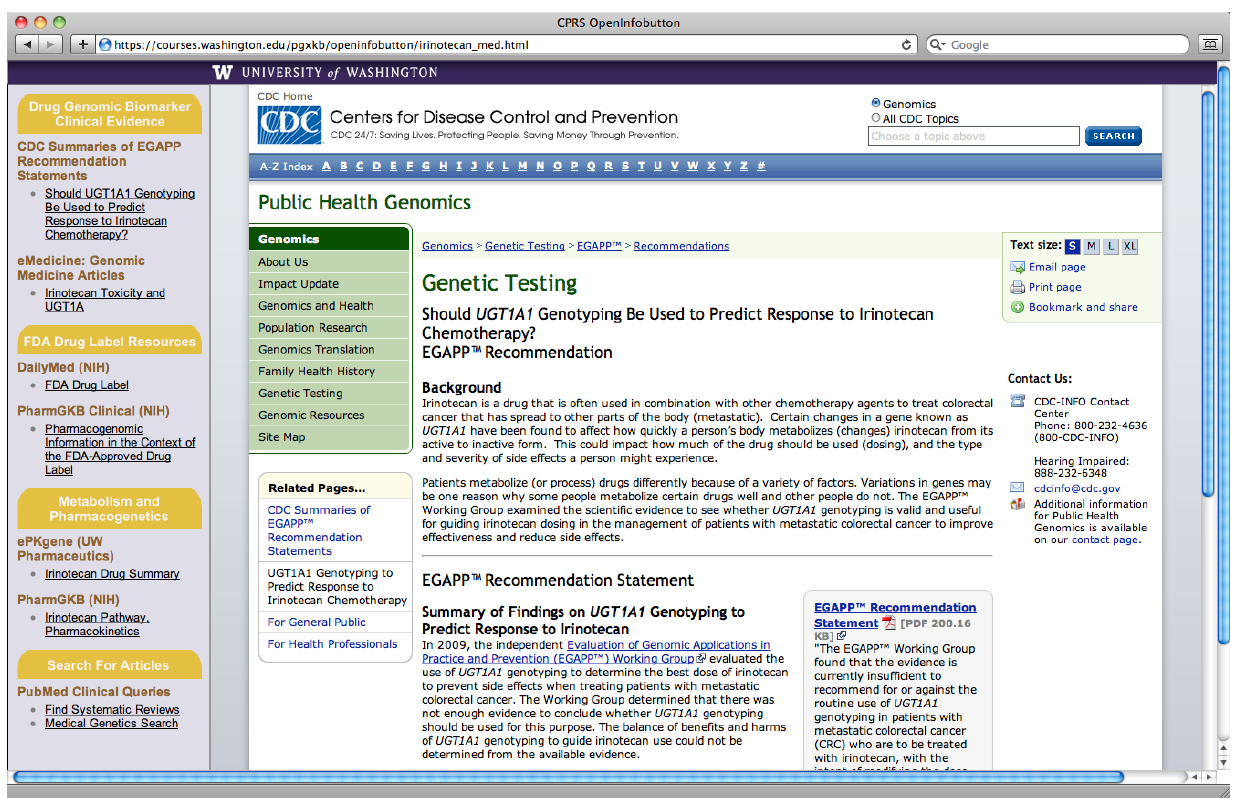
Figure 3. An example website generated using the OpenInfobutton Knoweldge base configured for this project and a customized HTML layout.